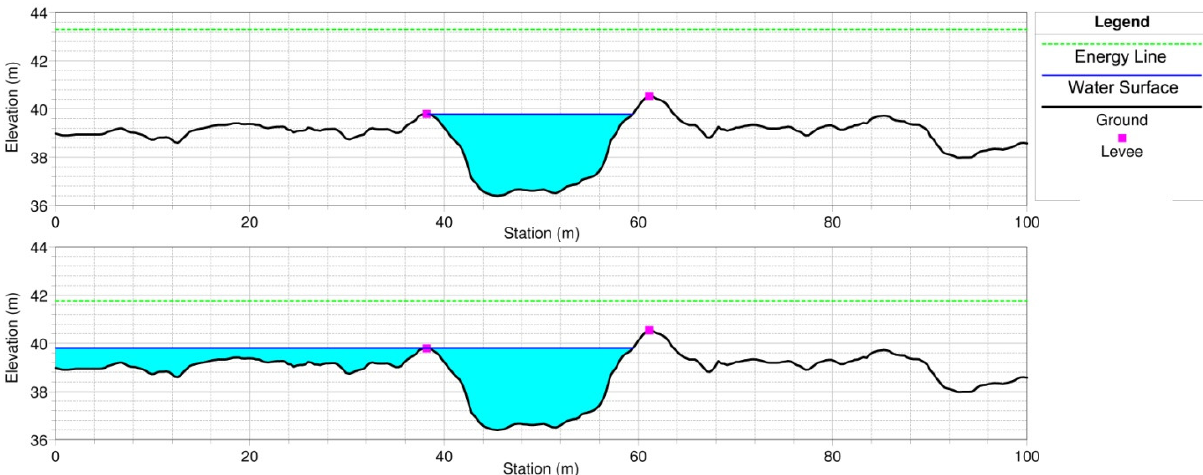
Figure 13. Water surface elevation and energy head before and after levee